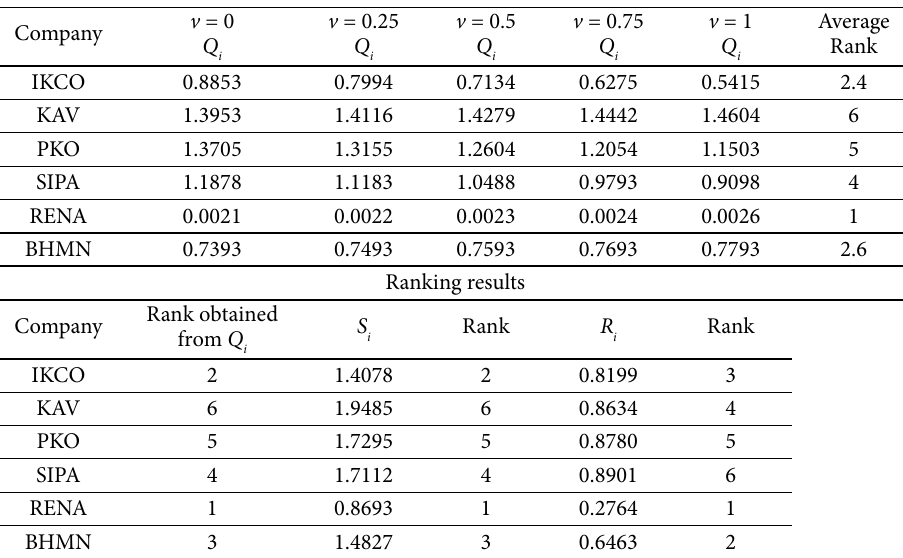
Table 6. The results of fuzzy VIKOR